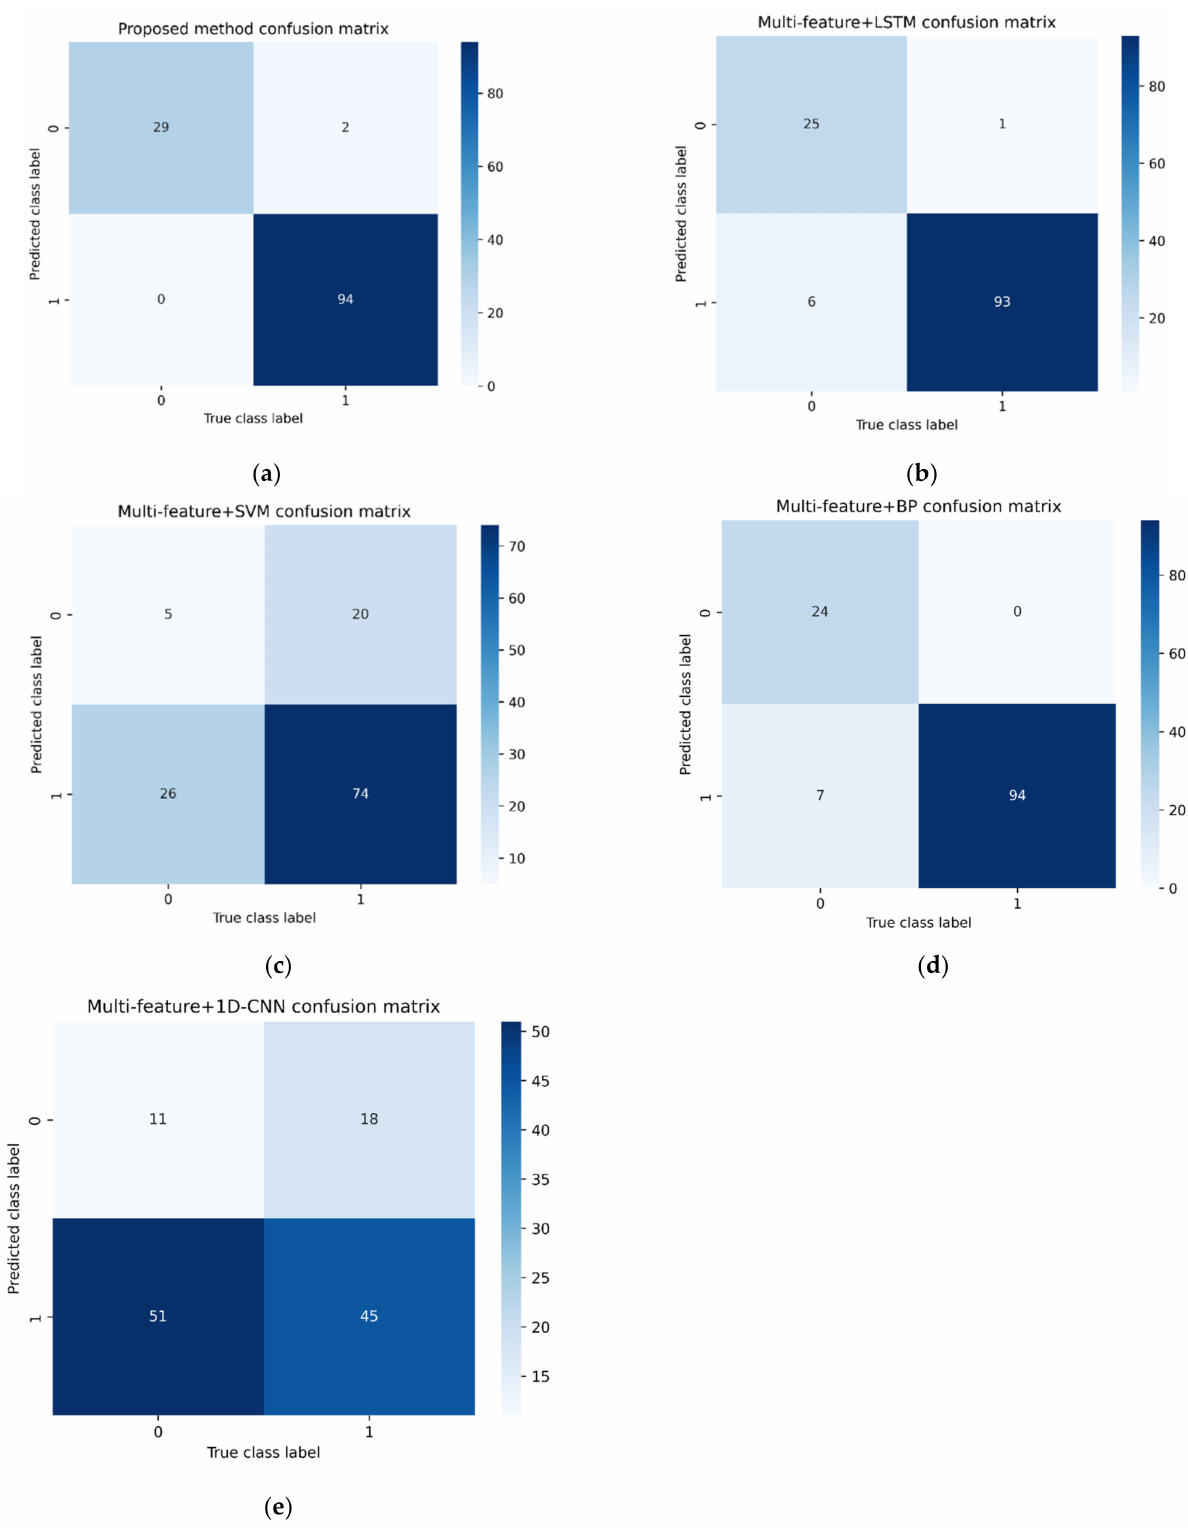
Figure 18. Confusion matrix of different methods: ( a ) Proposed method confusion matrix; ( b ) Multi- feature + LSTM confusion matrix; ( c ) Multi-feature + SVM confusion matrix; ( d ) Multi-feature + BP confusion matrix; ( e ) Multi-feature + 1D-CNN confusion